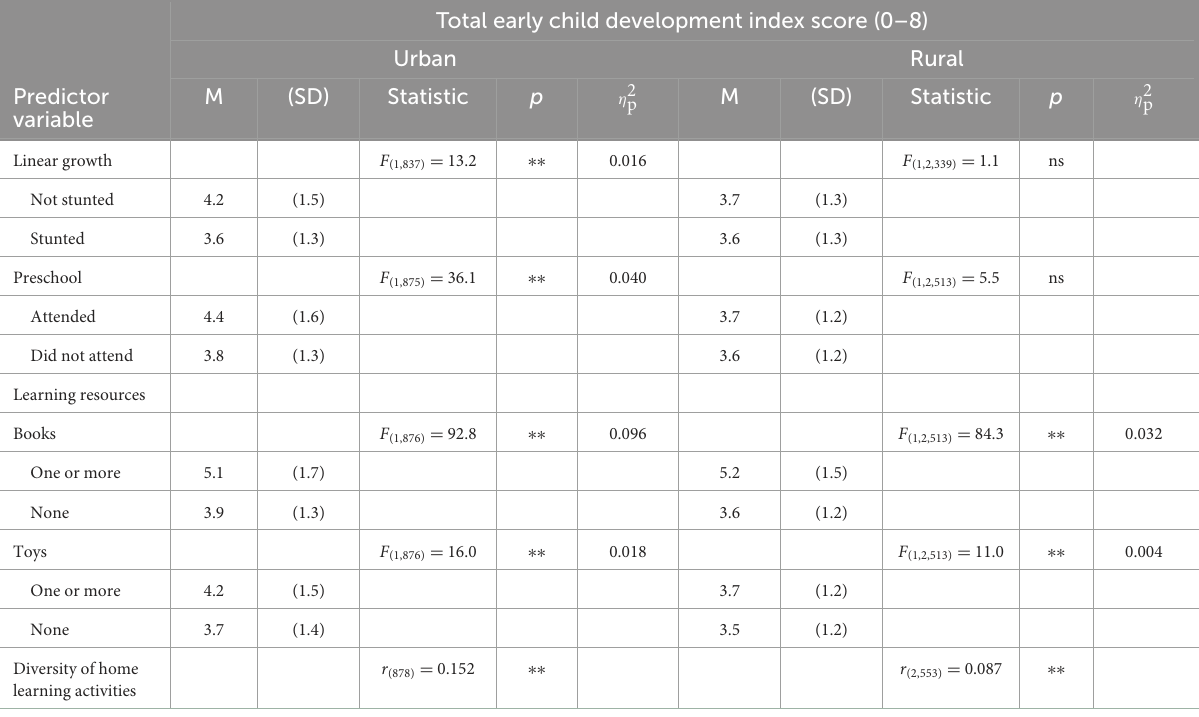
TABLE 8 Association between individual predictor variables and Early Child Development Index scores among urban and rural 36- to 59-month-old children in Côte d’Ivoire. Total early child development index score (0–8) Urban Rural Predictor variable Linear